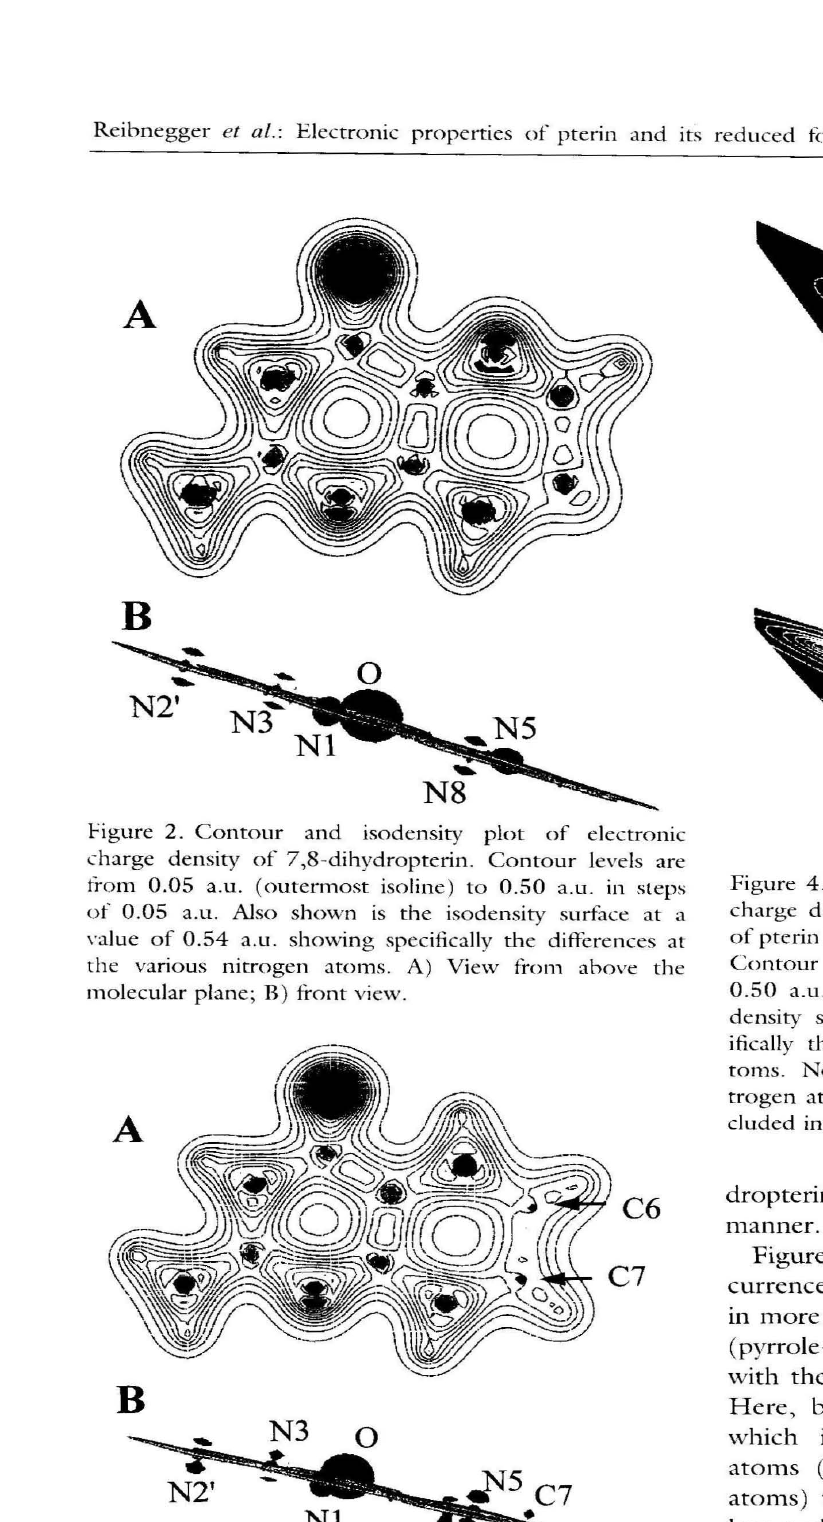
Figure 3. Contour and isodensity plot of electronic charge density of 5,6,7,8-tetrahydropterin. Contour levels are from 0.05 a.u. (outermost isoline) to 0.50 a.u. in steps of 0.05 a.u. Also ShO"V11 is the isodensity surface at a value of 0.54 a.u. showing specifically the differences at the various nitrogen atoms. A) View from above the molecular plane; B) front view. Notably, the ring carbon atoms C6 and C7 no longer are placed in the same plane as the remaining ring atoms (this is visualized by their inner core electronic densities indicated in the Figure).